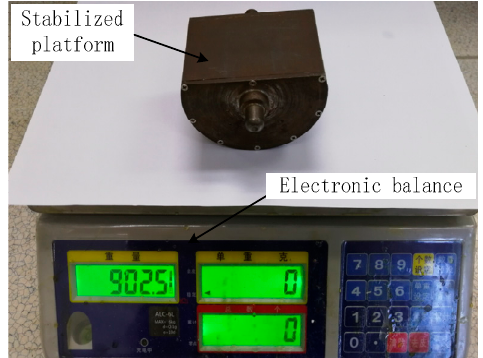
Figure 12. Quality of the SSP before optimization.